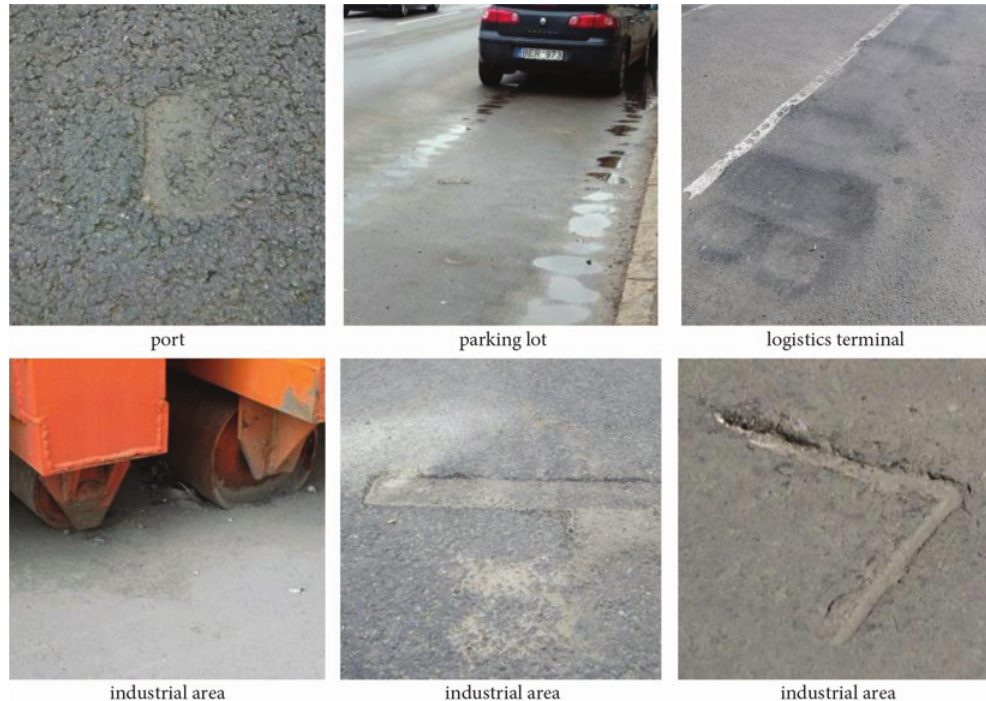
fig. 1. Examples of permanent deformation observe in pavements of special